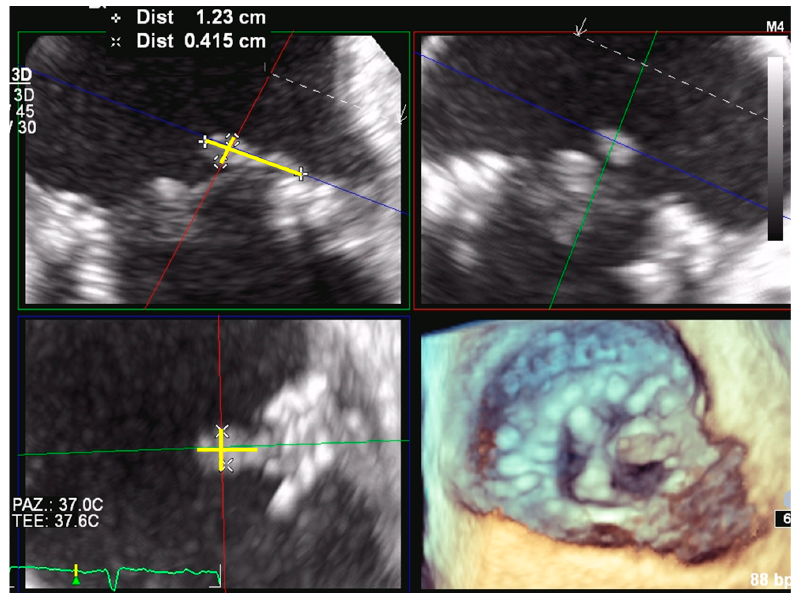
Figure 7. Bioprosthetic mitral valve endocarditis. Multiplanar reconstruction allows proper alignment of the planes perpendicular to the long and short axis of the mobile vegetation at the left atrial side of the mitral prosthesis. This approach ensures we have more reliable 3D measurements of vegetation’s dimensions (yellow lines) that are important for guiding the therapeutic intervention.